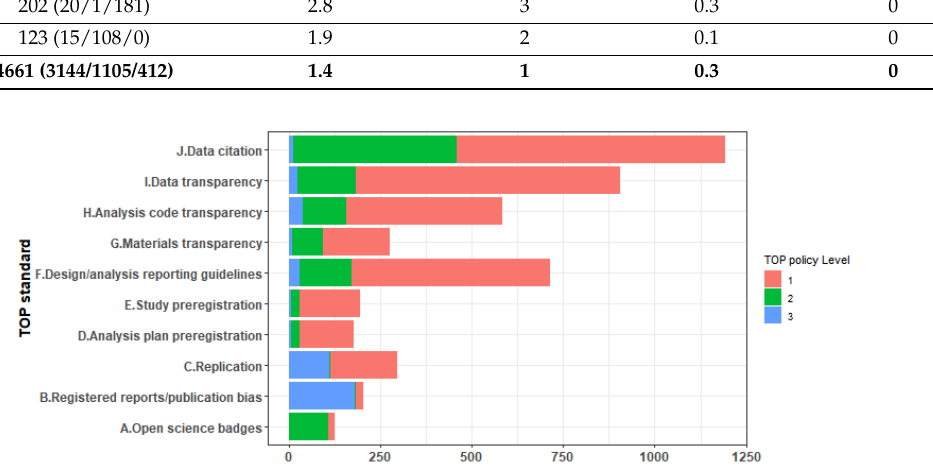
Figure 1. Histogram of the number of journals that adopt each individual TOP standard and corresponding stringency level. Stringency levels 1, 2 and 3 of each TOP standard are indicated in different colors, whereas each row is a single TOP standard.